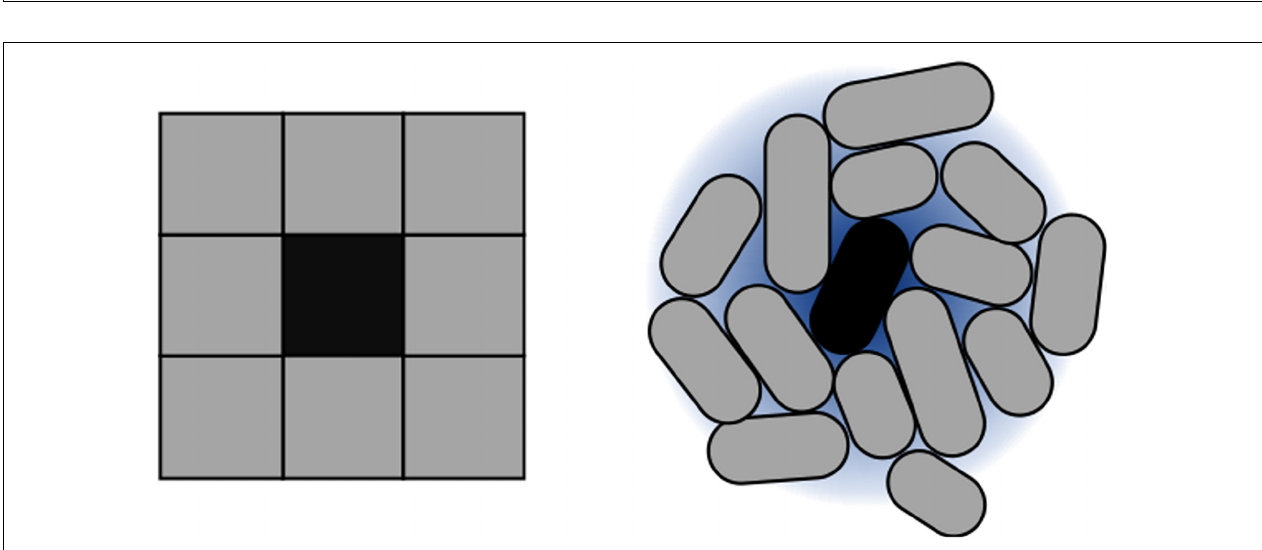
FIGURE 4 | Approximation of Moore neighborhood using cells. CA execution is strongly dependent on the concept of neighborhood. 2D CA typically work on a Moore neighborhood. To reproduce this idea in the context of cell colonies, autoinducer sensing is used. The size of the neighborhood is dependent directly on the reach of the autoinducers. In terms of our simulation model, this is represented through diffusion and degradation values of the intercellular signal.